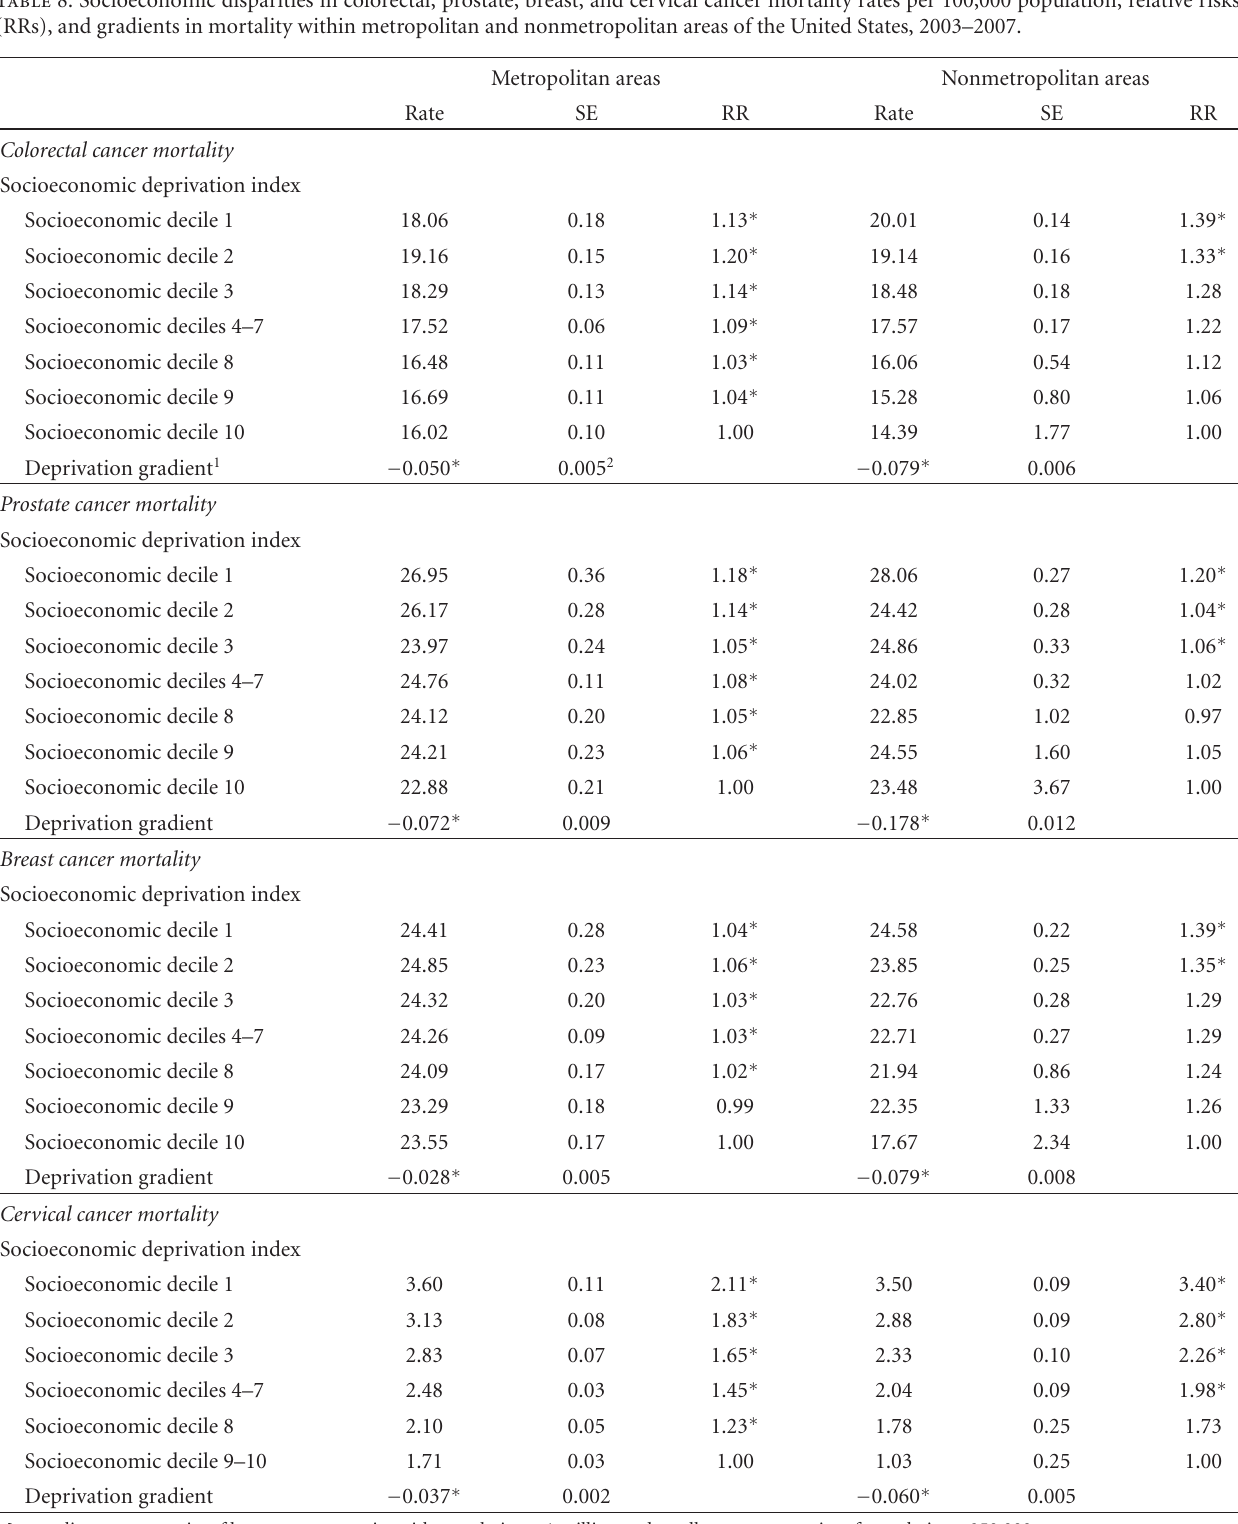
Table 8: Socioeconomic disparities in colorectal, prostate, breast, and cervical cancer mortality rates per 100,000 population, relative risks (RRs), and gradients in mortality within metropolitan and nonmetropolitan areas of the United States,